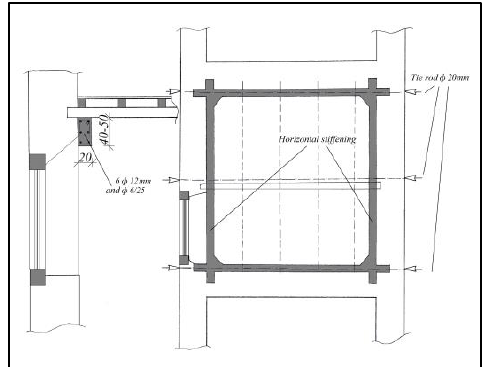
Figure 27. Tie-beam position and reinforced concrete beams at the ground floor foundation. Figure 27. Captain’s house dating from 1842, before and at the beginning of reconstruction.